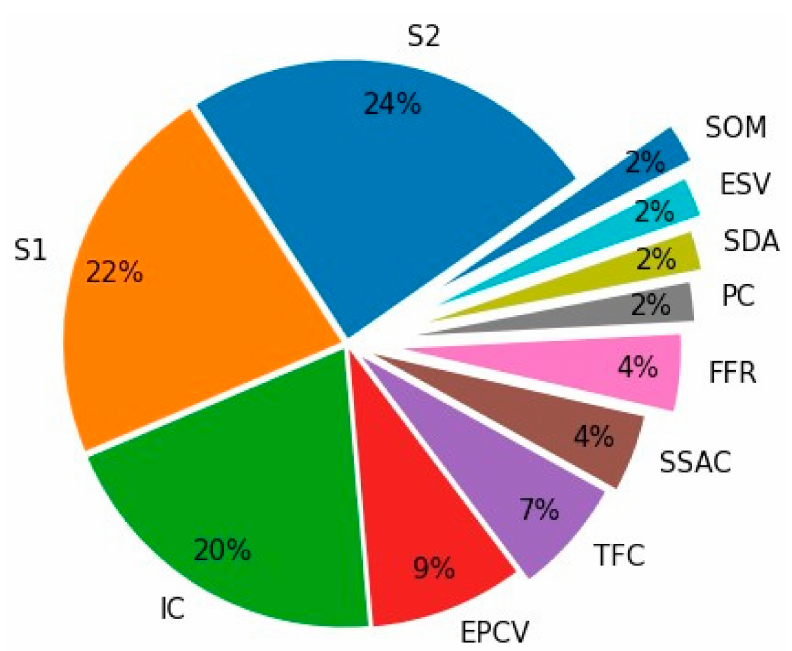
Figure 14. Breakdown of the extracted